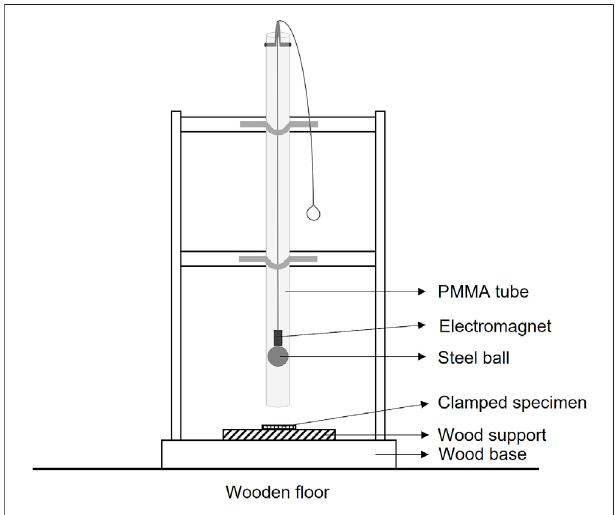
FIGURE1| Schematicdiagramoftheimpact setupusedtodamagethe